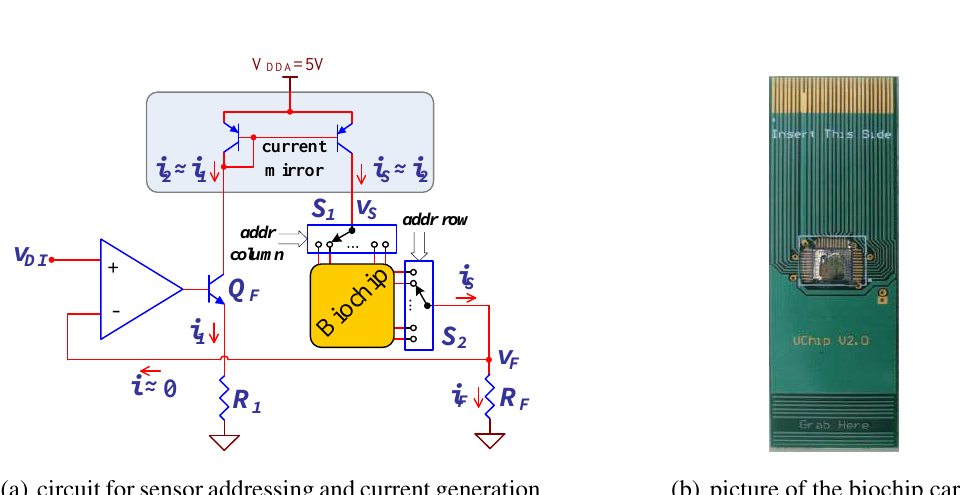
Figure 4. Biochip electric drive and